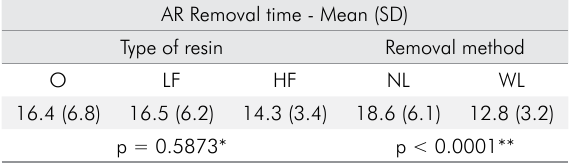
Table 3. Time (in seconds) for removal of adhesive remnants (AR), considering the different systems tested (O: Opaque; LF: low fluorescence; HF: high fluorescence) and the methods for removing AR (NL: no UV light; WL: With UV